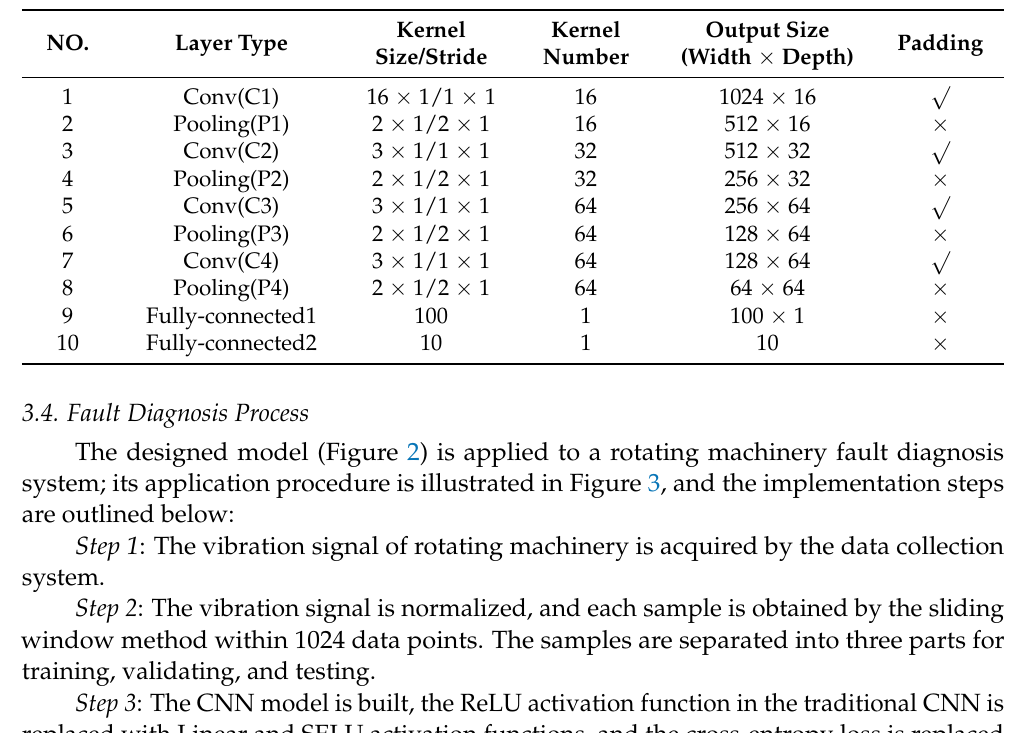
Table 1. Parameters of the proposed